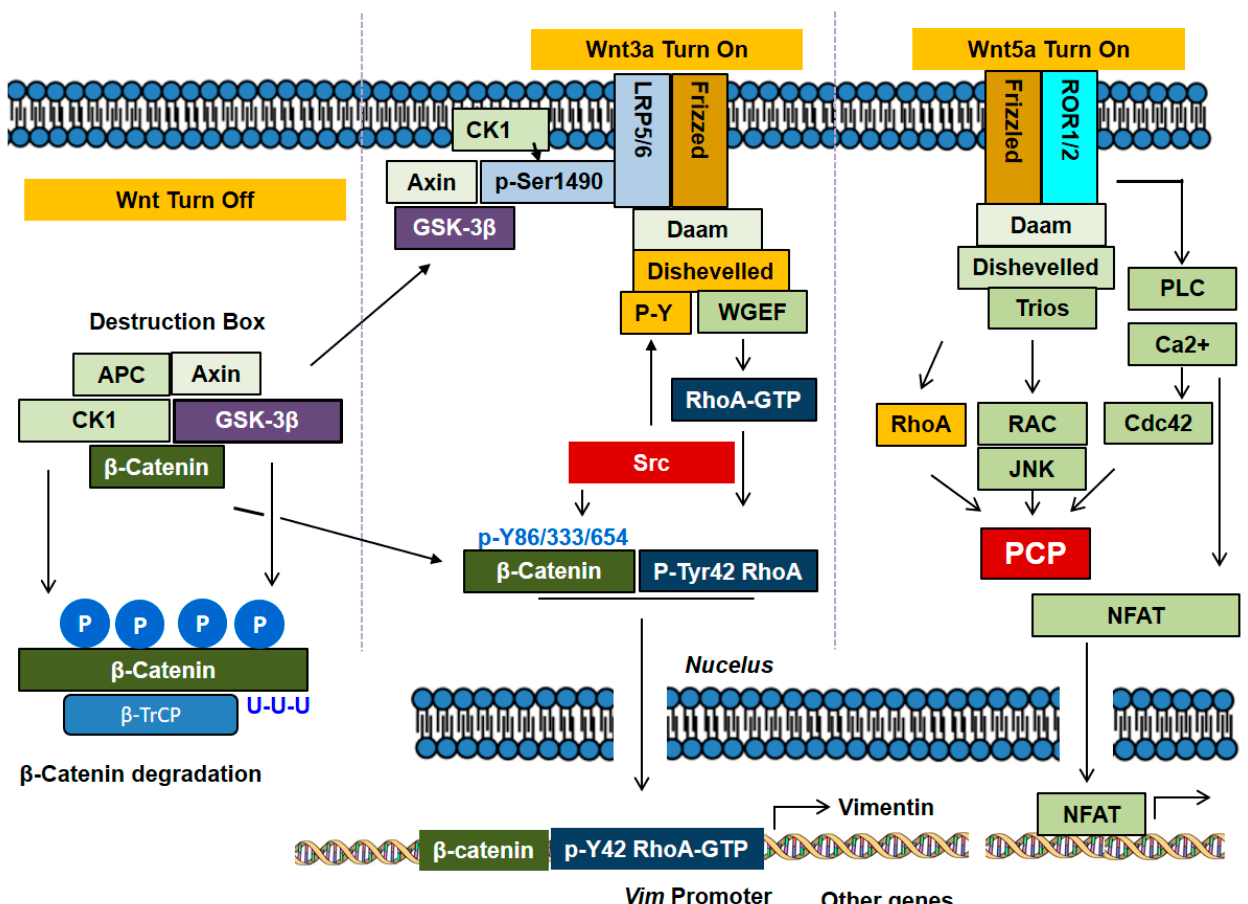
Figure 3. Canonical and non-canonical signaling pathways of Wnts . In absence of Wnt, β -catenin associates with APC, Axin, CK1 and GSK-3 β to form the complex of destruction box. CK1 phosphorylates Ser45 in β -catenin, a priming step, and GSK-3 β subsequently phosphorylates Ser41, Ser37 and Ser33 in β -catenin, leading to polyubiquitylation by β -TrCP, E3 ubiquitin ligase, and degradation. In the canonical pathway, Wnt3a stimulates the receptors Frizzled and LRP5/6, which recruit Axin